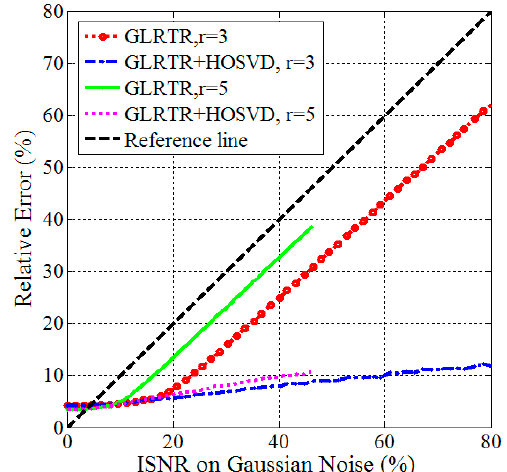
Figure 6. Relative errors versus different Inverse Signal-to-Noise Ratio (ISNR) on Gaussian noise.